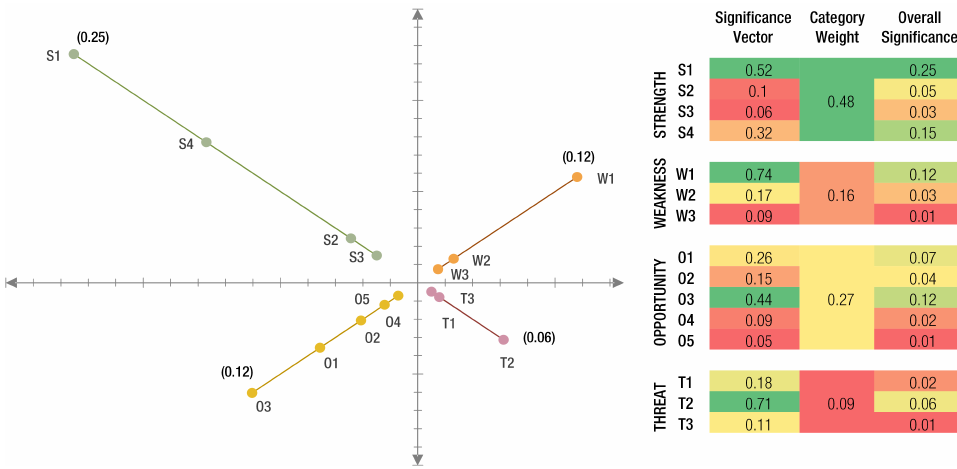
Figure 7. The perception map of the SWOT